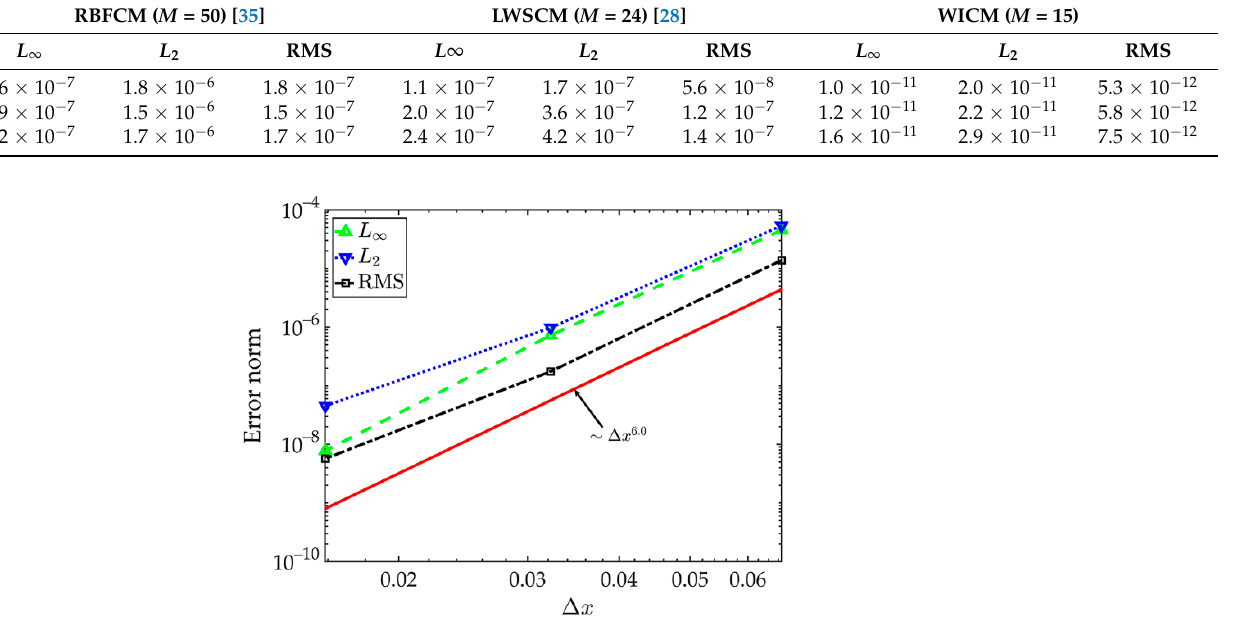
Figure 1. Error norms of the present wavelet solution at t = 4 as a function of Δ x = 2 − m for Example 1 with c = 0.5.